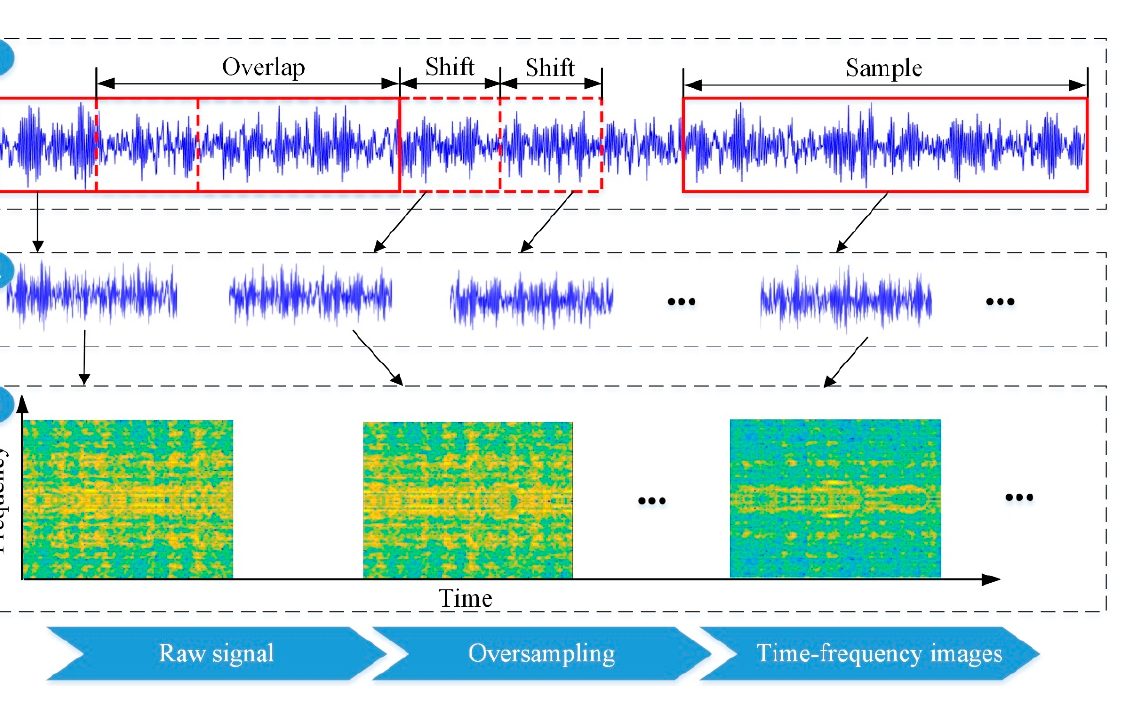
Figure 2. Signal preprocessing process. Table 3. Detailed settings of the